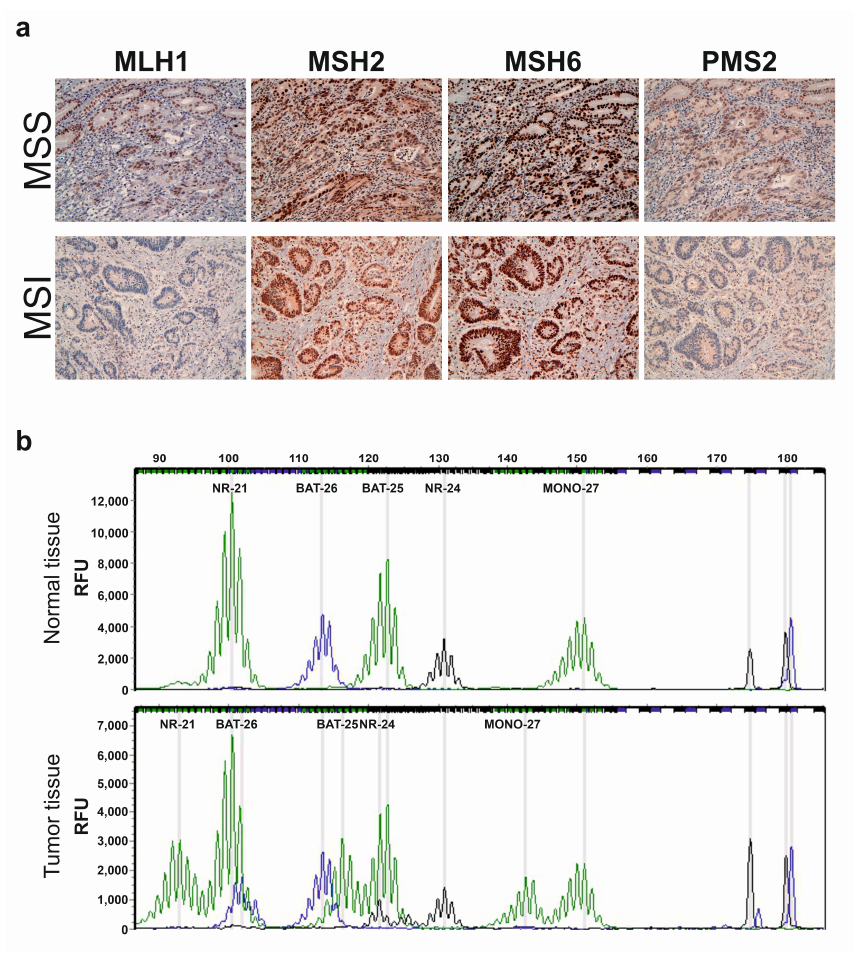
Figure 1. Representative IHC staining for MMR proteins and electropherograms of multiplex PCR analysis using the MSI Analysis System Version 1.2 kit. ( a ) MLH1, MSH2, MSH6 and PSM2 expression in FFPE samples of a MSS and a MSI patient by IHC (original magnification 20 × ). The MSS patient shows normal expression of all MMR proteins. Deficiency in MLH1 and PSM2 proteins is observed in the MSI patient; ( b ) Multiplex PCR electropherograms show profiles of 5 quasimonomorphic microsatellites (NR-21, BAT-26, BAT-25, NR-24 and MONO-27) in the normal and tumor tissue of the same patient. The tumor tissue shows additional peaks that are absent in the normal tissue of all microsatellites analyzed, revealing an MSI